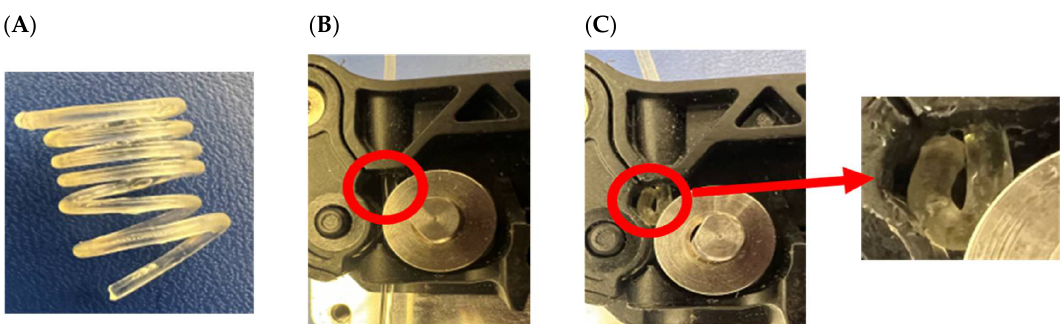
Figure 6. Change in the printability of the DXM extrudate after 180 days of storage. ( A ) Highly elastic filament due to the over-plasticization. ( B ) Filament at day 0 has good printability and easy passage through the gears of the printer. ( C ) Filament on day 180 caused clogging of the gears of the printer and cannot be printed.